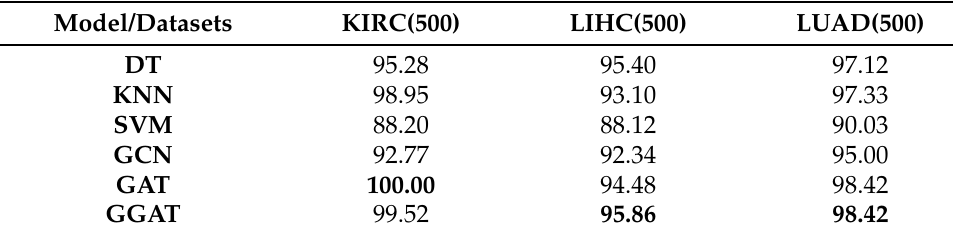
Table 12. Accuracy (%) of Models Under 500 Feature Dimensions.